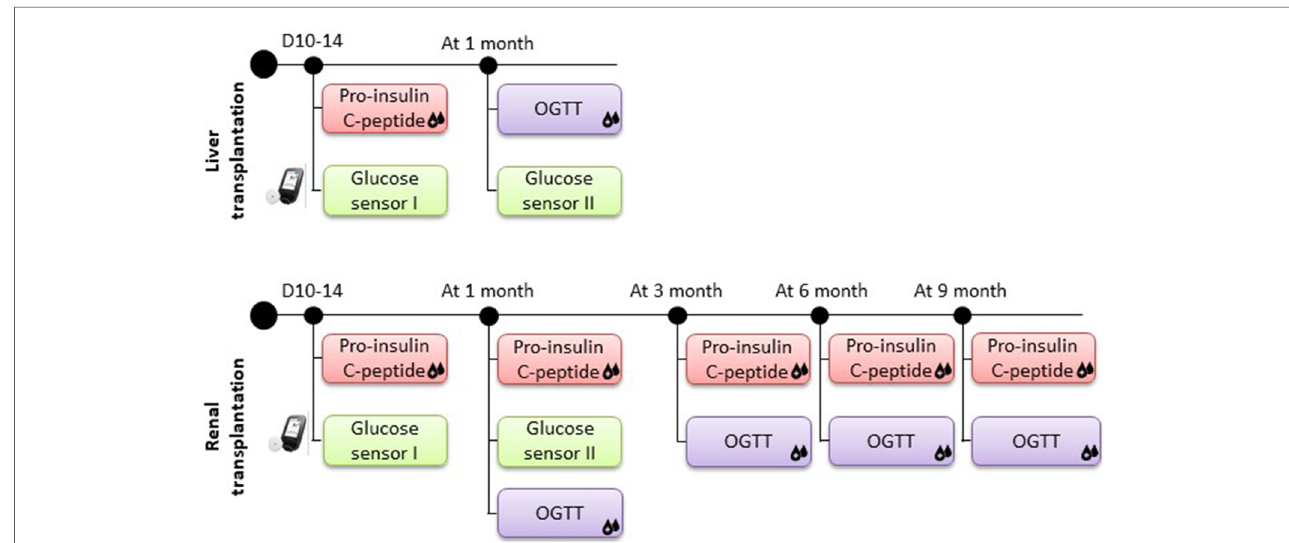
FIGURE 1 Protocol of prospective DIABGRAFT study. For LT and RT cohorts, pro-insulin and C-peptide secretion was measured after two weeks of transplant and measures had continued at one, three, six and nine months for RT patients. A glucose sensor was placed on the patient two weeks post-transplant for one month to detect the presence of early dysglycemia. An OGTT was performed after one month of transplantation and, for RT patients also at three, six and nine